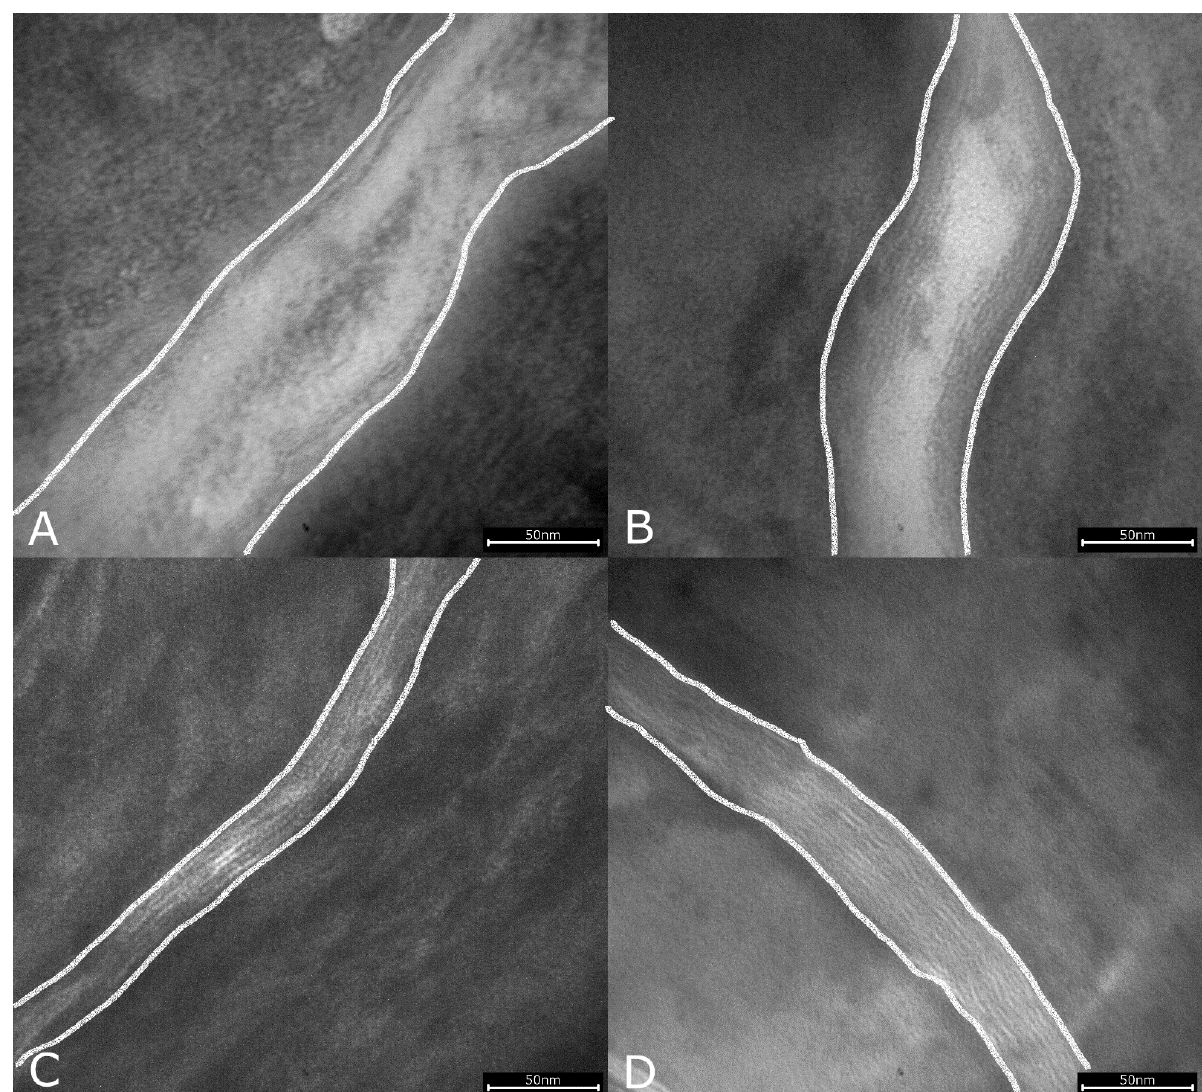
Figure 8. Reduced intercellular lipid lamellae (transitions from the corneocytes to the intercellular space marked with lines) in lesional skin of classic atopic dermatitis ( A ), atopic prurigo ( B ), and non-atopic prurigo nodularis ( C ) compared with healthy controls ( D ) shown by electron microscopy (245.000-fold magnification).